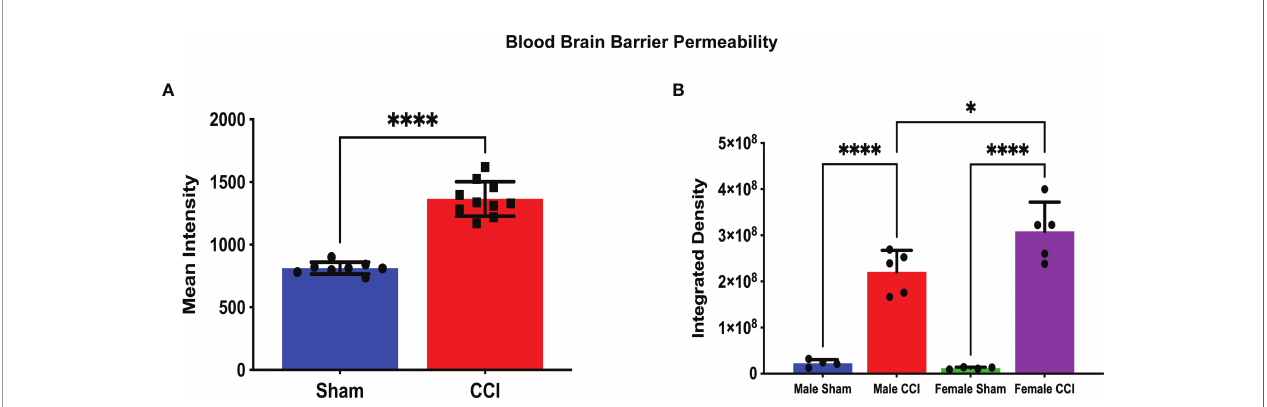
FIGURE 2 | Blood-Brain Barrier Permeability as measured by Alexa Fluor Dye extravasation. In this analysis, a minimum threshold of 1.5k was set for detection of BBB permeability; this threshold was set to eliminate any artifact fl uorescence that may be detected by the scanner. The measurements displayed are the mean intensity of dye for all CCI rats compared to all sham rats (A) and the mean integrated density for each group (B) . There was a signi fi cant difference in the mean intensity of dye extravasation when comparing all sham rats to all CCI rats ( A ; CCI mean intensity = 1365 ± 43.61, sham mean intensity = 813.2 ± 16.66, p < 0.0001). The integrated density is the sum of detected fl uorescence of dye in a speci fi c area of cerebral tissue. A higher integrated density indicates a more permeable BBB in a speci fi c area of cerebral tissue. Both the female CCI (mean integrated density = 3.08 x 10 8 ± 2.83 x 10 7 ) and the male CCI (2.20 x 10 8 ± 4.05 x 10 6 ) groups recorded higher mean intensities compared to their respective sham group (female sham mean = 1.20 x 10 7 ± 1.08 x 10 6 , male sham mean = 2.25 ± 4.05 x 10 6 ). The female CCI group did record a higher integrated density compared to the male group, and this difference did reach statistical signi fi cance (mean difference = 87893520 ± 26653677, p = 0.0210). (****p < 0.0001, *p <